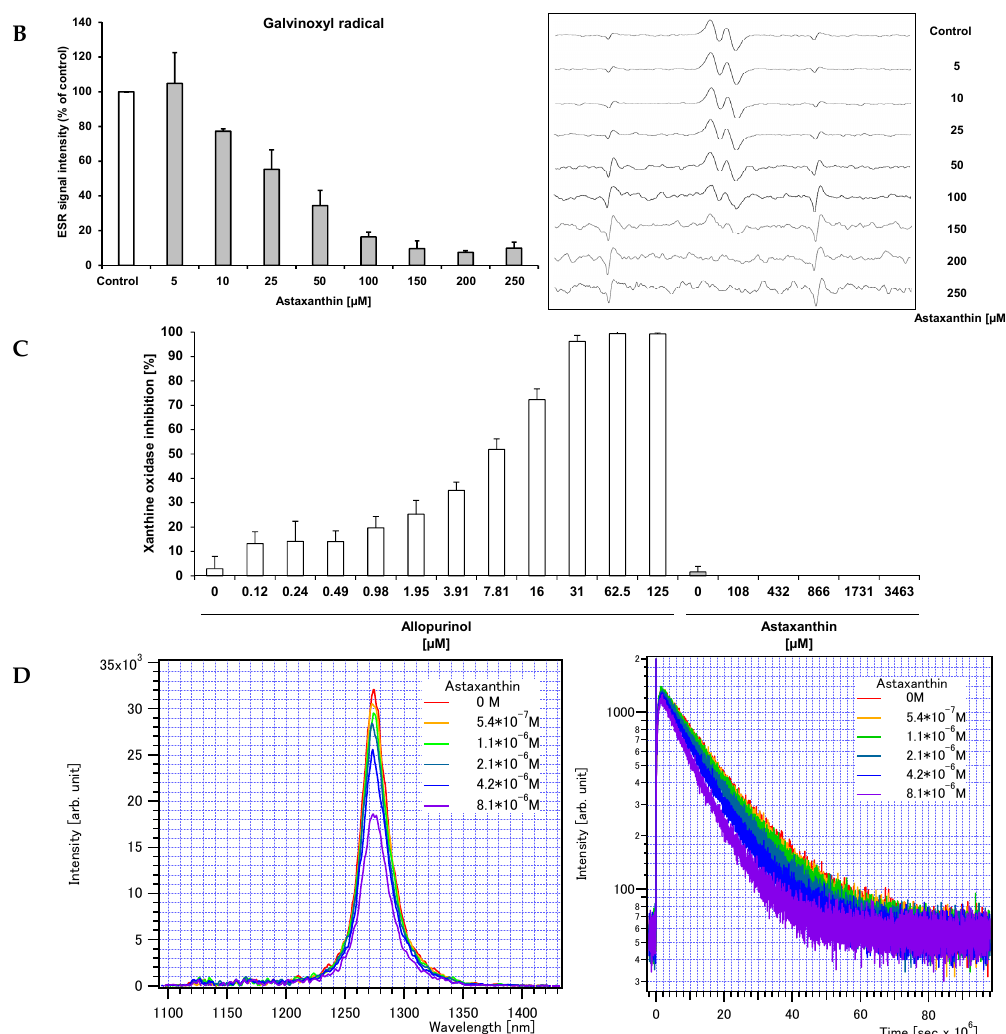
Figure 2. Scavenging effects of astaxanthin on DPPH radical ( A ), galvinoxyl radical ( B ), xanthine oxidase inhibition ( C ), and quenching of singlet oxygen ( D ). ( A ) The reaction mixture contained 500 μ M DPPH and the given concentration of astaxanthin. All values are means + SD (experiments performed in triplicate); ( B ) Various astaxanthin concentrations were mixed with 500 μ M galvinoxyl. Changes in the radical signal intensity are shown on the right side of the figure. All values are means + SD (three independent experiments performed in triplicate); ( C ) The reaction mixture contained 5 U/mL xanthine oxidase in 50 mM potassium phosphate buffer and the given astaxanthin concentrations. Allopurinol was used as a positive control. All values are means + SD (three independent experiments performed in triplicate); ( D ) Singlet oxygen quenching activity of astaxanthin as a function of concentration (5.4 × 10 − 7 , 1.1 × 10 − 6 , 2.1 × 10 − 6 , 4.2 × 10 − 6 , and 8.1 × 10 − 6 M astaxanthin), wavelength ( left ), and time ( right ). Photo emission was determined by a photon complex after laser irradiation at 532 nm in the presence of the test sample. Two independent experiments performed in duplicate. In our cell culture studies, astaxanthin did not exhibit any significant cytotoxicity in concentrations of up to 20 μ M in Huh7, PON1-Huh7, and HepG2 as summarized in Figure 3. TritonX was used as a control to induce cytotoxicity as determined by the neutral red assay.